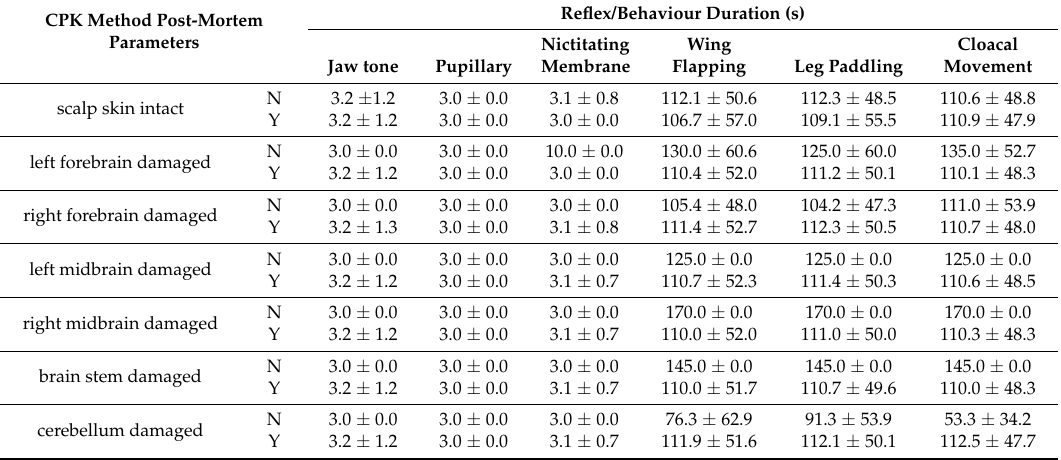
Table 4. Mean ( ± SD) duration (s) of reflexes and behaviours post CPK method application in relation to achieved (Y/N) post-mortem